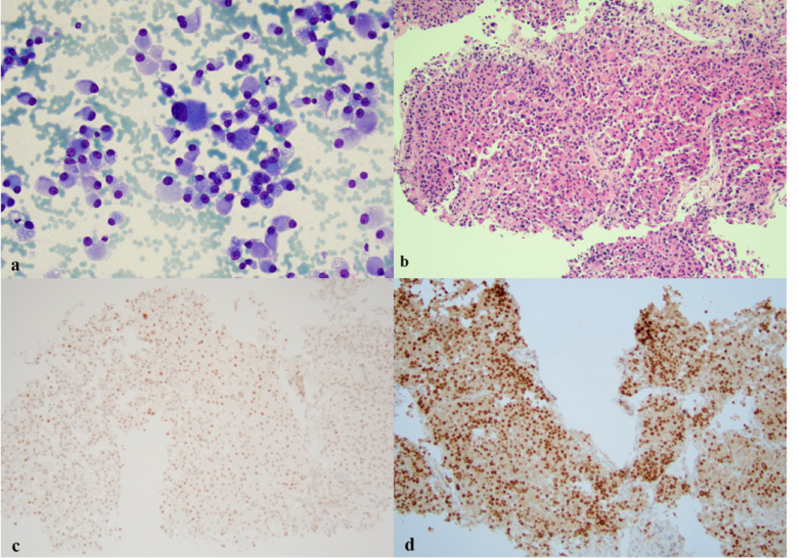
Figure 4. Adrenal cortical carcinoma. ( a ) The malignant cells are plasmacytoid and characterized by abundant cytoplasm and eccentric nuclei on a smear ( × 400, Diff-Quik). ( b ) A small core biopsy comprised of malignant cells with abundant eosinophilic cytoplasm ( × 200, H and E). ( c ) INSM1 shows nuclear staining on small core biopsy ( × 200, IHC). ( d ) SF1 demonstrates nuclear staining on small core biopsy ( × 200,